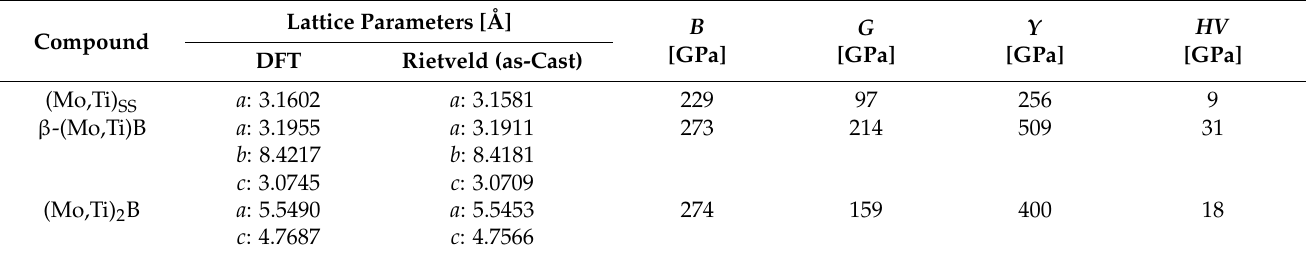
Table 3. Lattice parameters of the reduced cell (that is the non-supercell): bulk modulus, B; shear modulus, G; Young’s modulus, Y; Vickers hardness, HV of the Mo-Ti solid solution and the intermetallics β -(Mo,Ti)B and (Mo,Ti) 2 B.